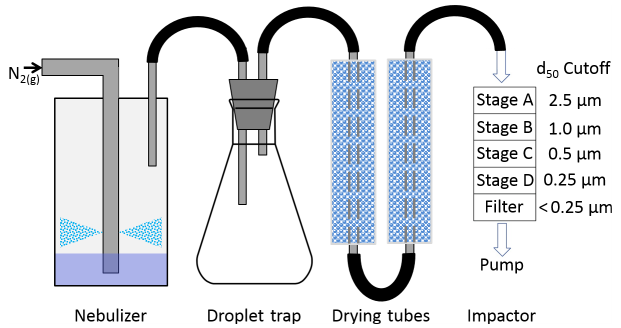
Figure 1. Schematic of the aerosol generation setup used to neb- ulize, dry, and collect the lab-generated aerosols. Running through the drying tubes are smaller mesh tubes surrounded by silica gel desiccant (represented in